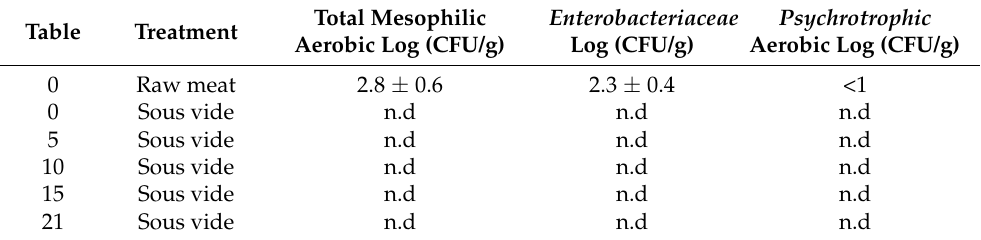
Table 4. Microbiological Counts of the Raw Chicken Breast Fillet 24 h Post-Mortem (Day 0) and Sous Vide Chicken Breast Fillets (Cooked at All Different Combinations of Temperature and Time) during 21 Days of Storage at 4 ◦ C. Enterobacteriaceae Psychrotrophic Total Mesophilic Table Treatment Aerobic Log (CFU/g) Log (CFU/g) Aerobic Log (CFU/g) 0 Raw meat 2.8 ± 0.6 2.3 ± 0.4 <1 Sous